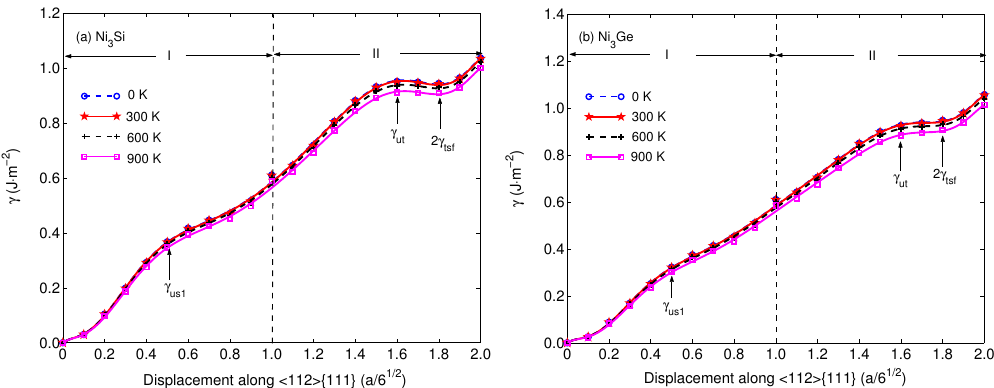
Figure 6. Temperature effects on the generalized planar fault energy curves of ( a ) Ni 3 Si and ( b ) Ni 3 Ge, respectively. The discrete points denote the values from first-principles calculations and the curves represent the results from polynomial fitting. Table 2. Calculated various fault energies (J/m 2 ), relative barrier difference δ ut us ≡ γ ut − γ us (J/m 2 ) and twinnability τ a at different temperatures of Ni 3 Si and Ni 3